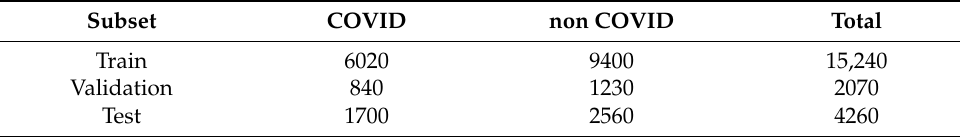
Table 3. Number of Slices After Training, Validation, and Test